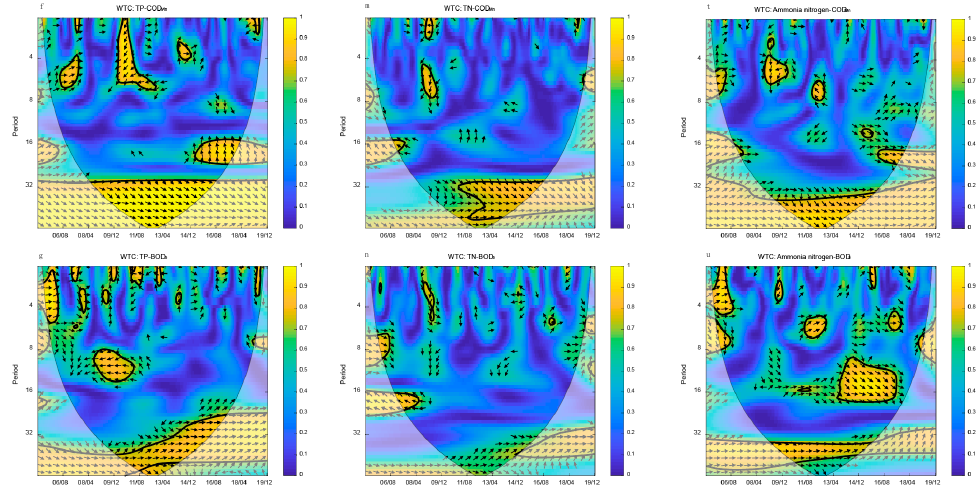
Figure 7. Wavelet transform coherence of the nutrient concentration. The thick black contour indicates a 95% confidence level against yellow noise and the cone of influence is shown as the lighter shade. The arrows (vectors) designate the phase difference (within-phase pointing right, anti-phase pointing left). The arrow to the left indicates negative phase coherence, and again the darker the color, the stronger the negative coherence. Y -axis period is month, the X -axis date format is year/month. ( a – g ) are WTC of TP and Temperature, pH, Flow, EC, DO, COD Mn , and BOD 5 . ( h – n ) are WTC of TN and Temperature, pH, Flow, EC, DO, COD Mn , and BOD 5 . ( o – u ) are WTC of NH + Temperature, pH, Flow, EC, DO, COD Mn , and BOD 5